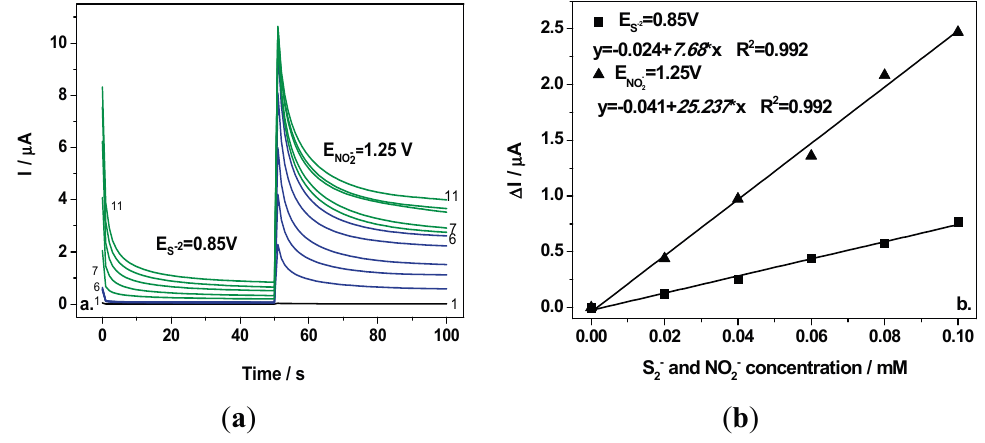
Figure 5. ( a ) Chronoamperograms recorded at BDD electrode in 0.1 M Na 2 SO 4 supporting electrolyte (curve 1) in the presence of 0.02–0.1 mM nitrite (curves 2–6) in a mixture of 0.02–0.1 mM sulfide and 0.1 mM nitrite (curves 7–11), at the potential values of E 1 = +0.85 V/SCE for sulfide and E 2 = +1.25 V/SCE for nitrite; ( b ) Calibration plot of the current vs . anion concentration recorded at E 1 = +0.85 V/SCE for sulfide (curves 7–11), respectively E 2 = +1.25 V/SCE (curves 2–6) for